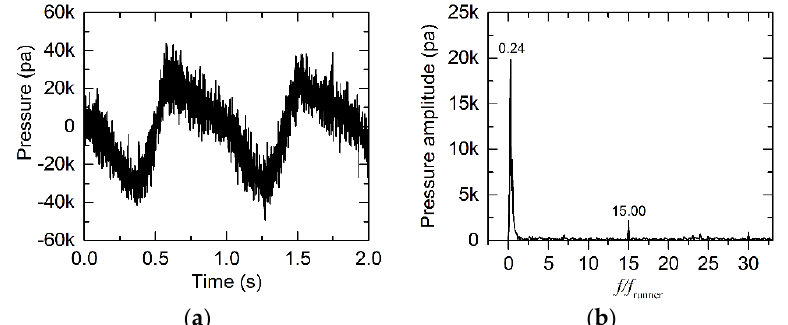
Figure 8. Pressure fluctuations of D 1 in the draft tube (16 deg GVO): ( a ) time history record and ( b ) normalized frequency spectrum.